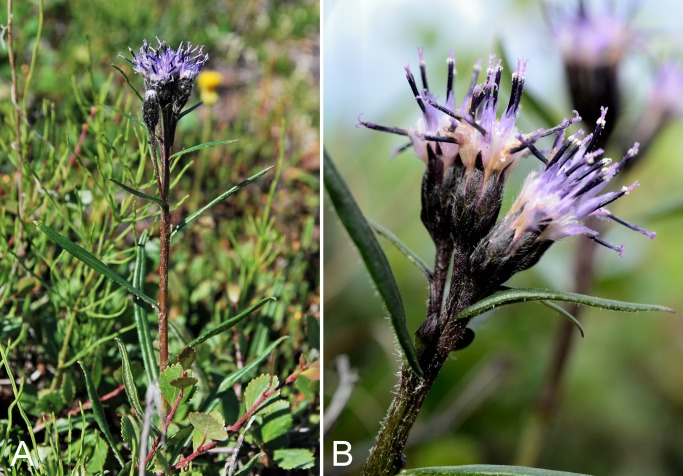
Saussurea angustifolia subsp. angustifolia.(A) Habit, Saarela et al. 3921. (B) Capitula, Kugluk (Bloody Falls) Territorial Park, Nunavut, 15 July 2014. Photographs by J. M. Saarela (A) and R. D. Bull (B).